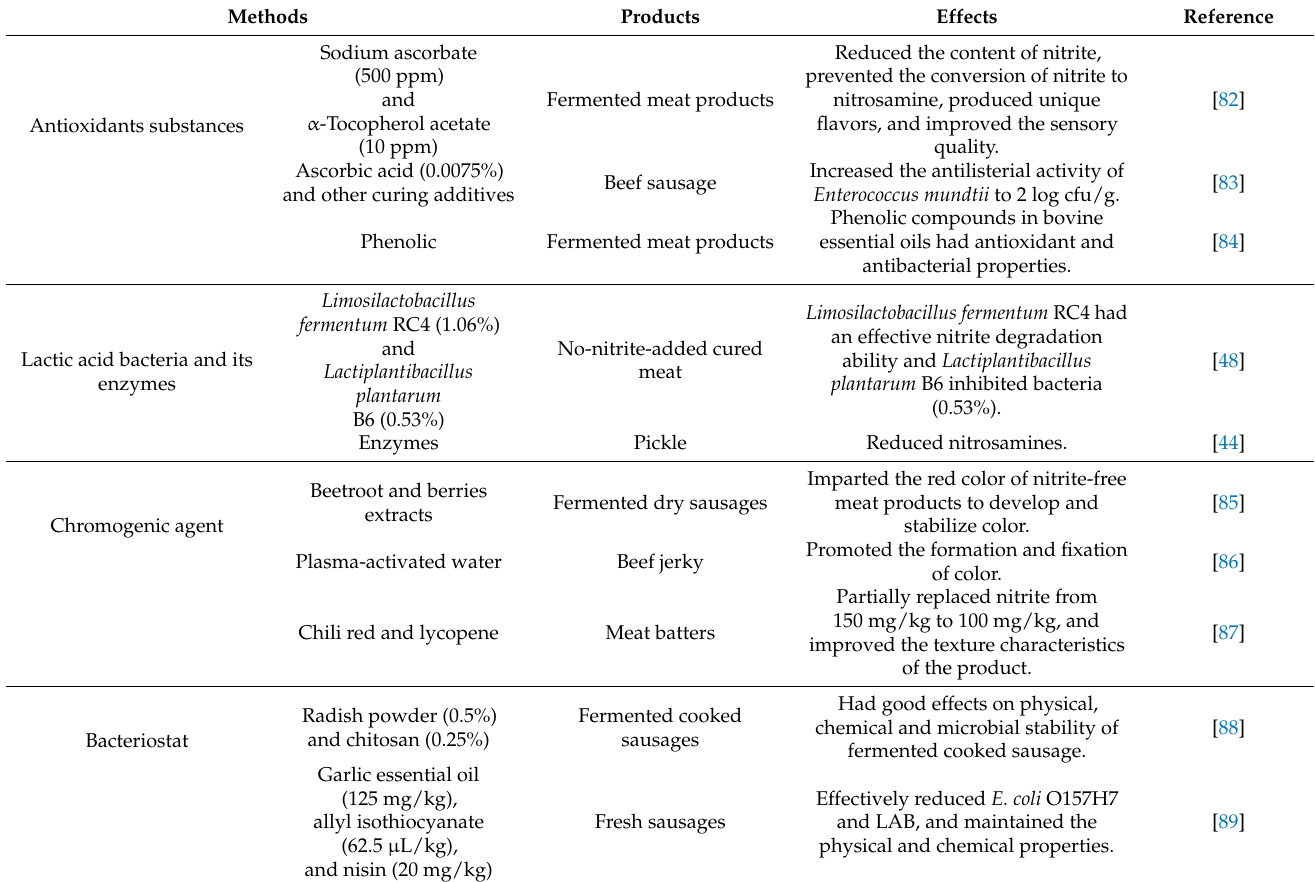
Table 2. Studies on reducing the nitrite content in fermented meat